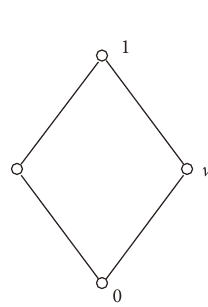
Figure 2: Lattice V